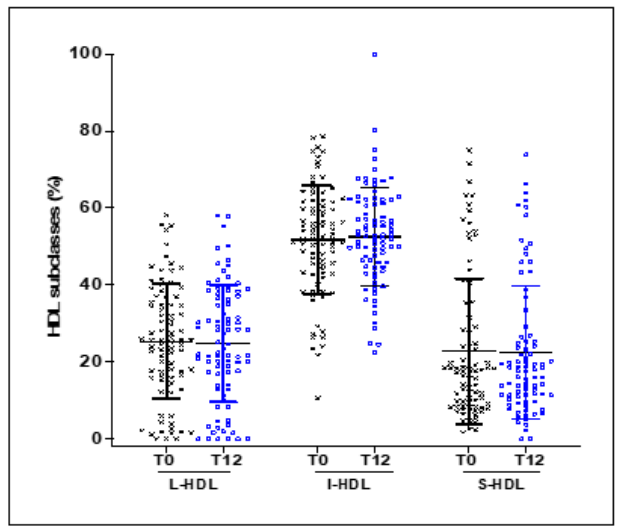
Figure 4. Effect of EVOO intake on the distribution of HDL subclasses. Plasma from 84 healthy young and elderly subjects was subjected to electrophoresis in 3% polyacrylamide Lipoprint® HDL gel tubes. The gel tubes were analyzed using Lipoware software. HDL was divided into 10 subfractions, which are presented here as L-HDL particles (subfractions 1 to 3), I-HDL particles (subfractions 4 to 7), and S-HDL particles (subfractions 8 to 10).